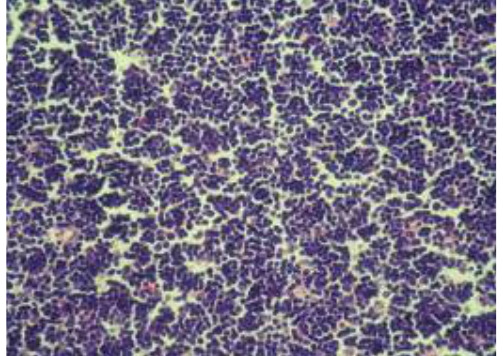
Fig. 5. Electronogram of thymocytes of pigs, 1 st group, the 70 nd day of test. x 6000